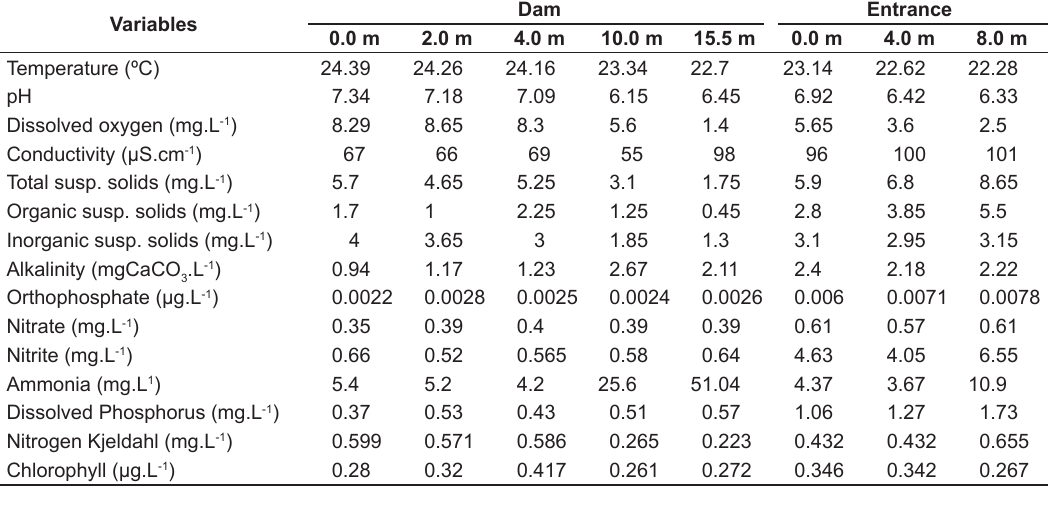
Table 2. Mean of environmental variables in entrance zone and dam of Itupararanga Reservoir.